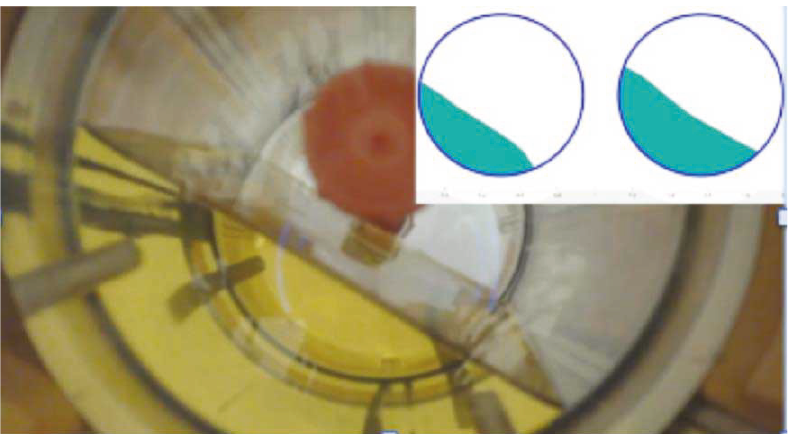
Figure 3: Video still from the roll and pitch manoeuvre showing optical (main) and ECT images. Optical video in the main picture and front and rear ECT images in embedded pictures. The ECT images are thresholded so that white is above 50% air, while green is above 50% propellant.